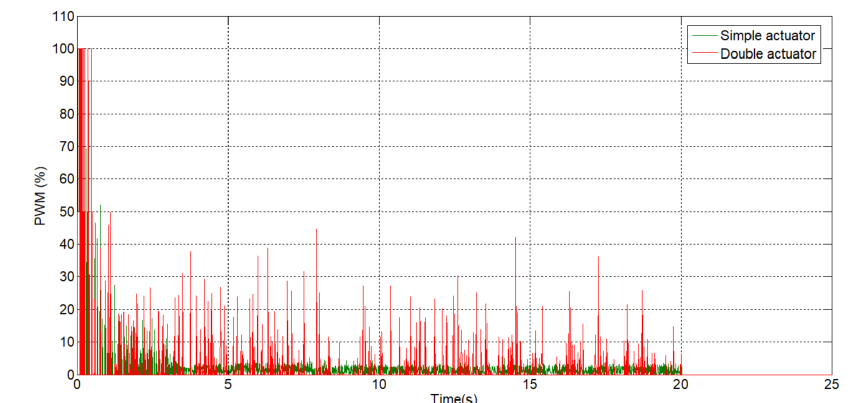
Figure 14. PWM control signal for double vs. simple actuator.